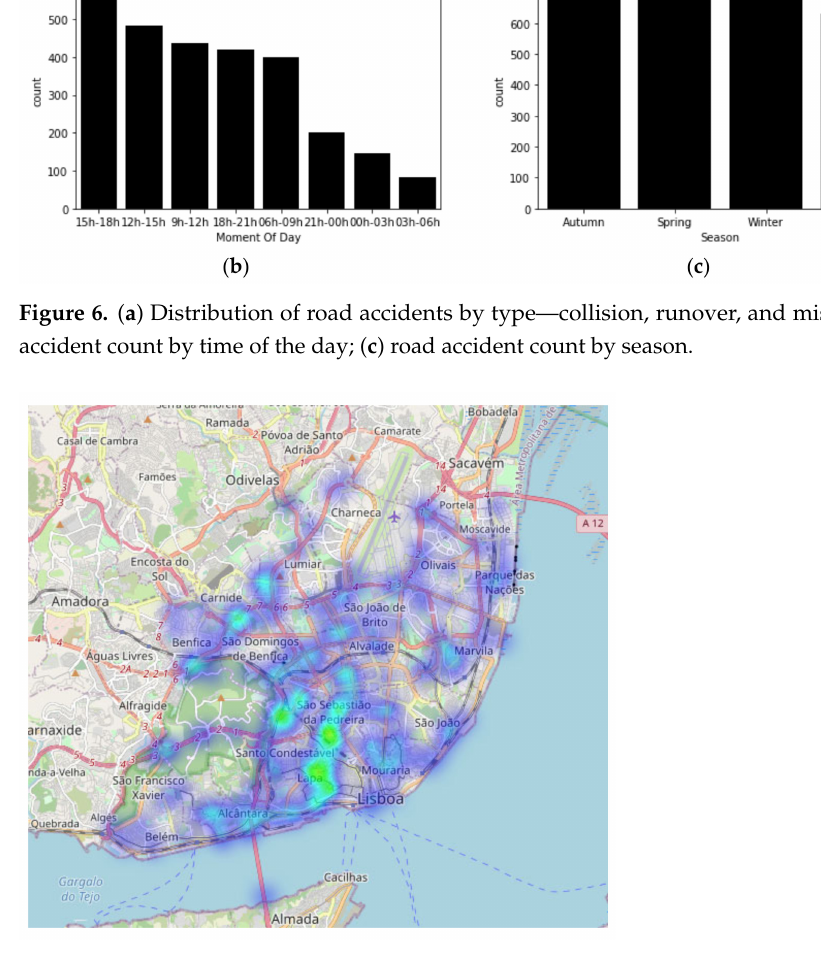
Figure 7. Mislead distribution in Lisbon in 2019. Orange and yellow represent streets where more misleads occurred; green and blue represent less common places for mislead